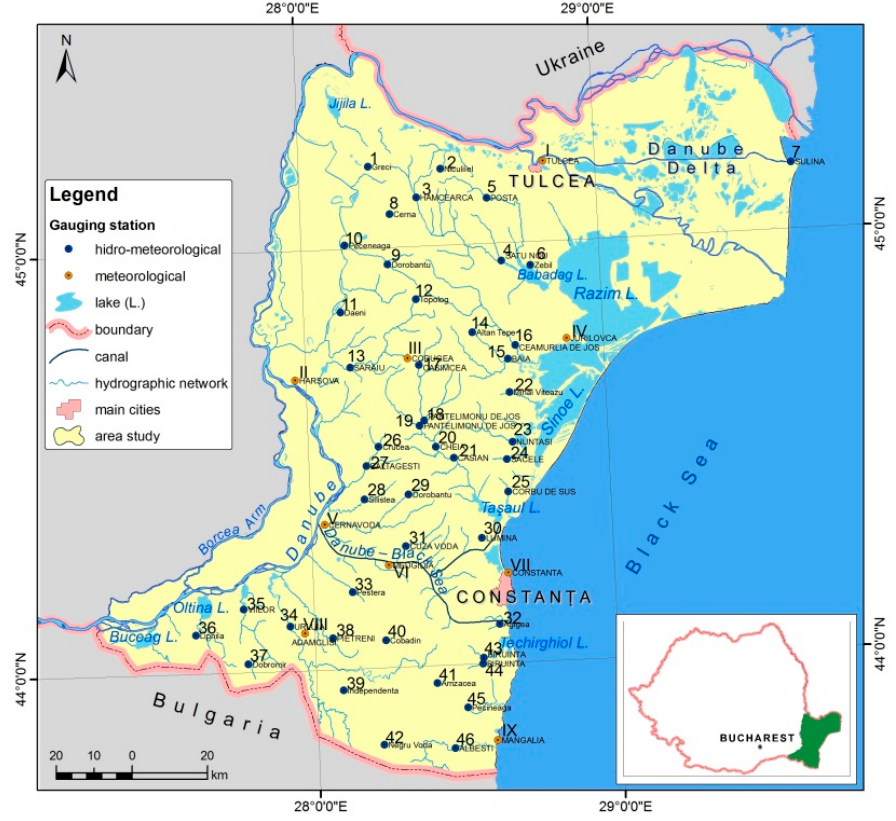
Figure 1. The map of the Dobrogea region and the stations where the data series were recorded.